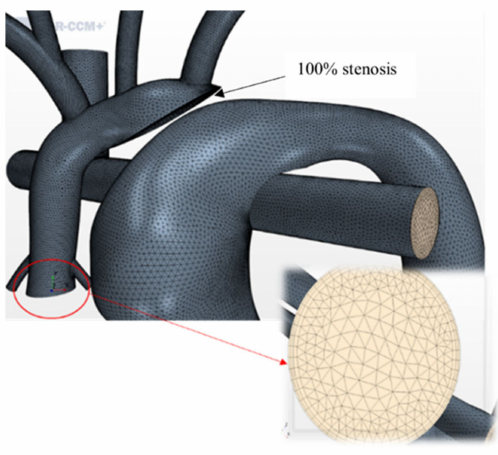
Figure 4. Meshed HCSII geometry with a close-up of the ascending aorta inlet